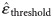
Simulated biomechanical cartilage degradation.Predicted biomechanical fixed charge density (FCD) losses in A) intact reference model and B) injury model. Biomechanical degradation shown at time t = 12 d was simulated with the degeneration threshold of ε^threshold = 50% of the maximum shear strain. This threshold was chosen to match model predictions and experimental findings.